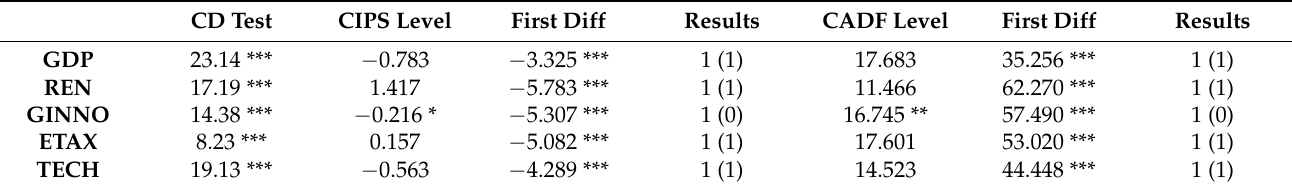
Table 4. Cross-section dependency test and second-generation unit test.